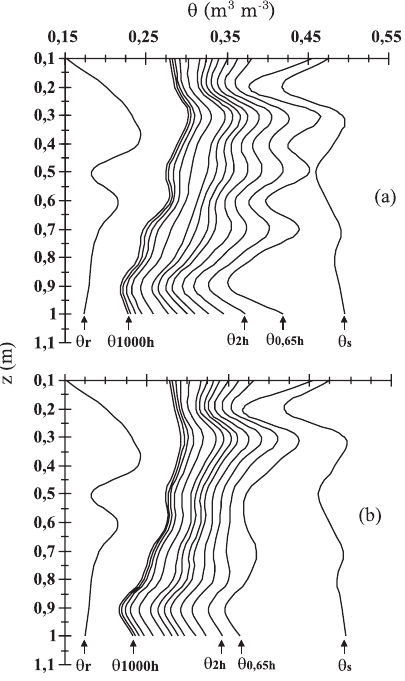
Figura 2. Variação do conteúdo hídrico em profundidade nos diferentes tempos de redistribuição nos tensiômetros da esquerda (a) e da direita (b). θθθθθ e θθθθθ são os parâmetros de ajuste r s da equação